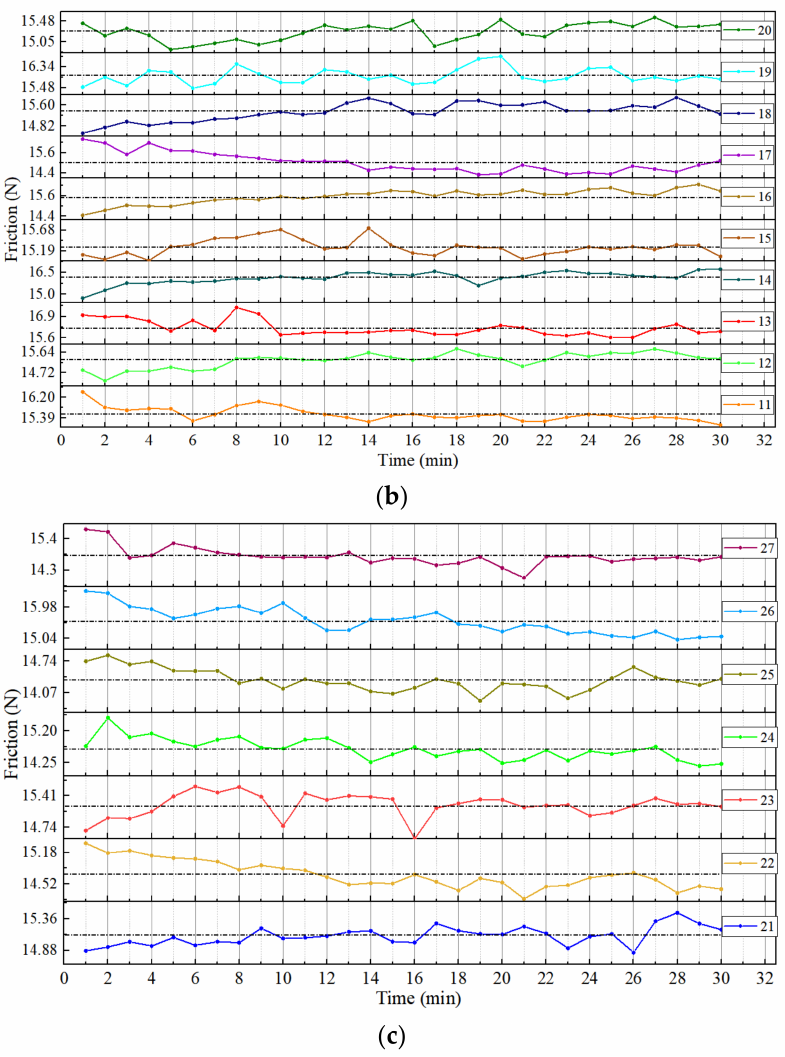
Figure 9. Frictional force values over the period 0–30 min. ( a ) is friction data for 1–10 sets of tests, ( b ) is friction data for 11–20 sets of tests, ( c ) is friction data for 21–27 sets of